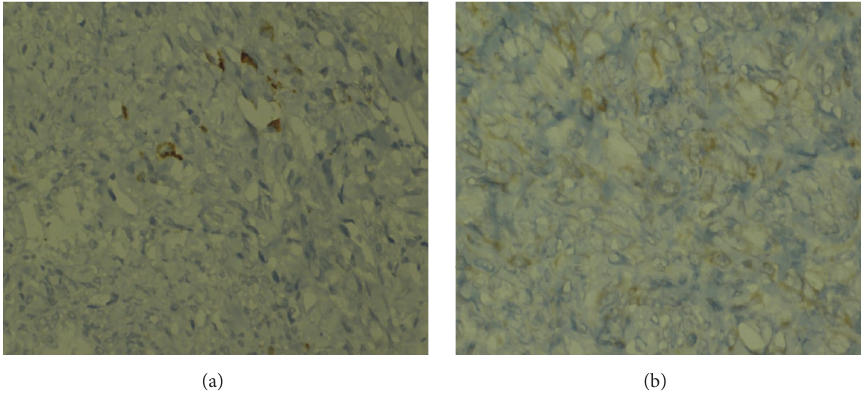
Figure 5: (a) Section showing focal positivity for cytokeratin. (b) Section showing focal positivity for Bcl 2.